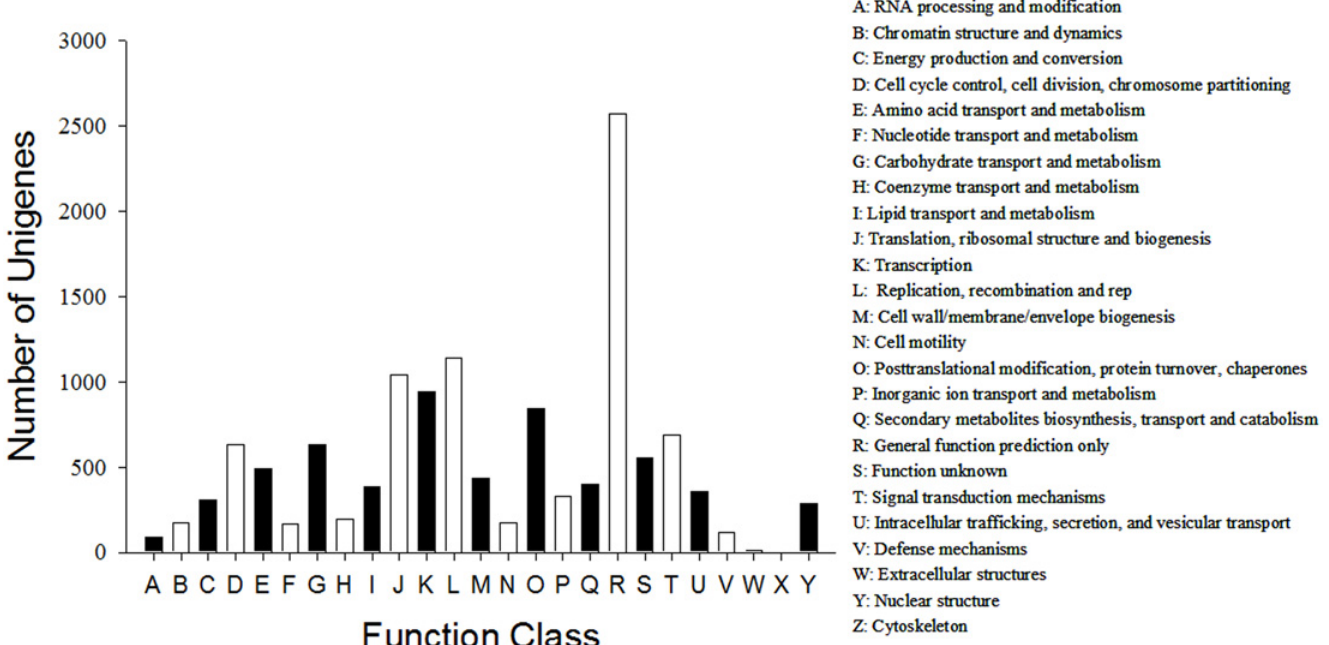
Fig 6. COG function classification. All unigenes were aligned to clusters of orthologous groups (COG) database at NCBI to predict possible functions. Out of 21,463 nr hits, 6,625 sequences had a COG classification among the 25 categories. The capital letters in x-axis indicate the COG categories as listed on the right and the y-axis indicates the number of unigenes in each